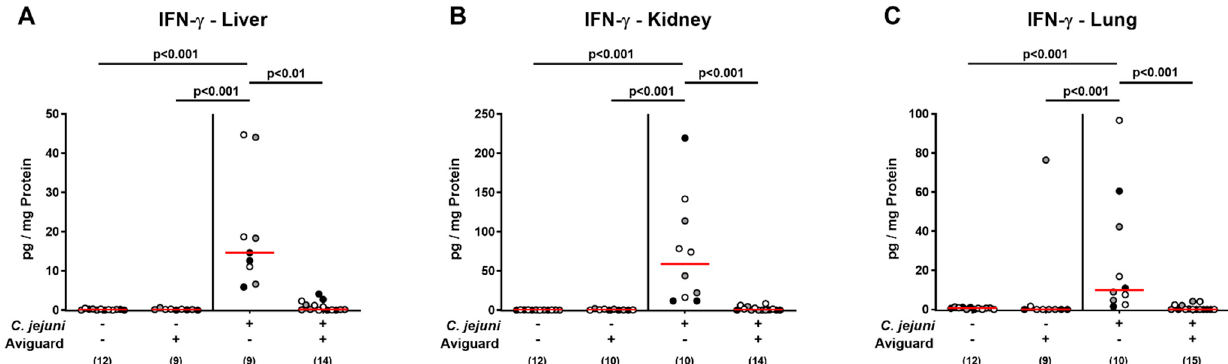
Figure 7. Aviguard ® treatment and extra-intestinal IFN- γ secretion in C. jejuni -infected microbiota-depleted IL-10 –/– mice. Following C. jejuni strain 81-176 infection on days 0 and 1, microbiota-depleted IL-10 –/– mice were perorally treated with Aviguard ® or placebo on days 2, 3, and 4. On day 6 post-infection, IFN- γ concentrations were measured in ex vivo biopsies derived from the ( A ) liver, ( B ) kidneys, and ( C ) lungs. Medians (red bars), significance levels ( p values) calculated by the Kruskal–Wallis test and Dunn’s post-correction, and numbers of analyzed mice (in parentheses) are indicated. Data were pooled from three independent experiments (as indicated by black, white, and gray circles).